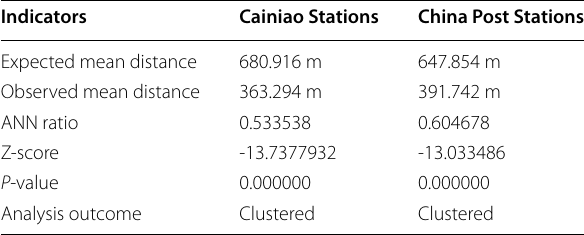
Table 1 The results of ANN